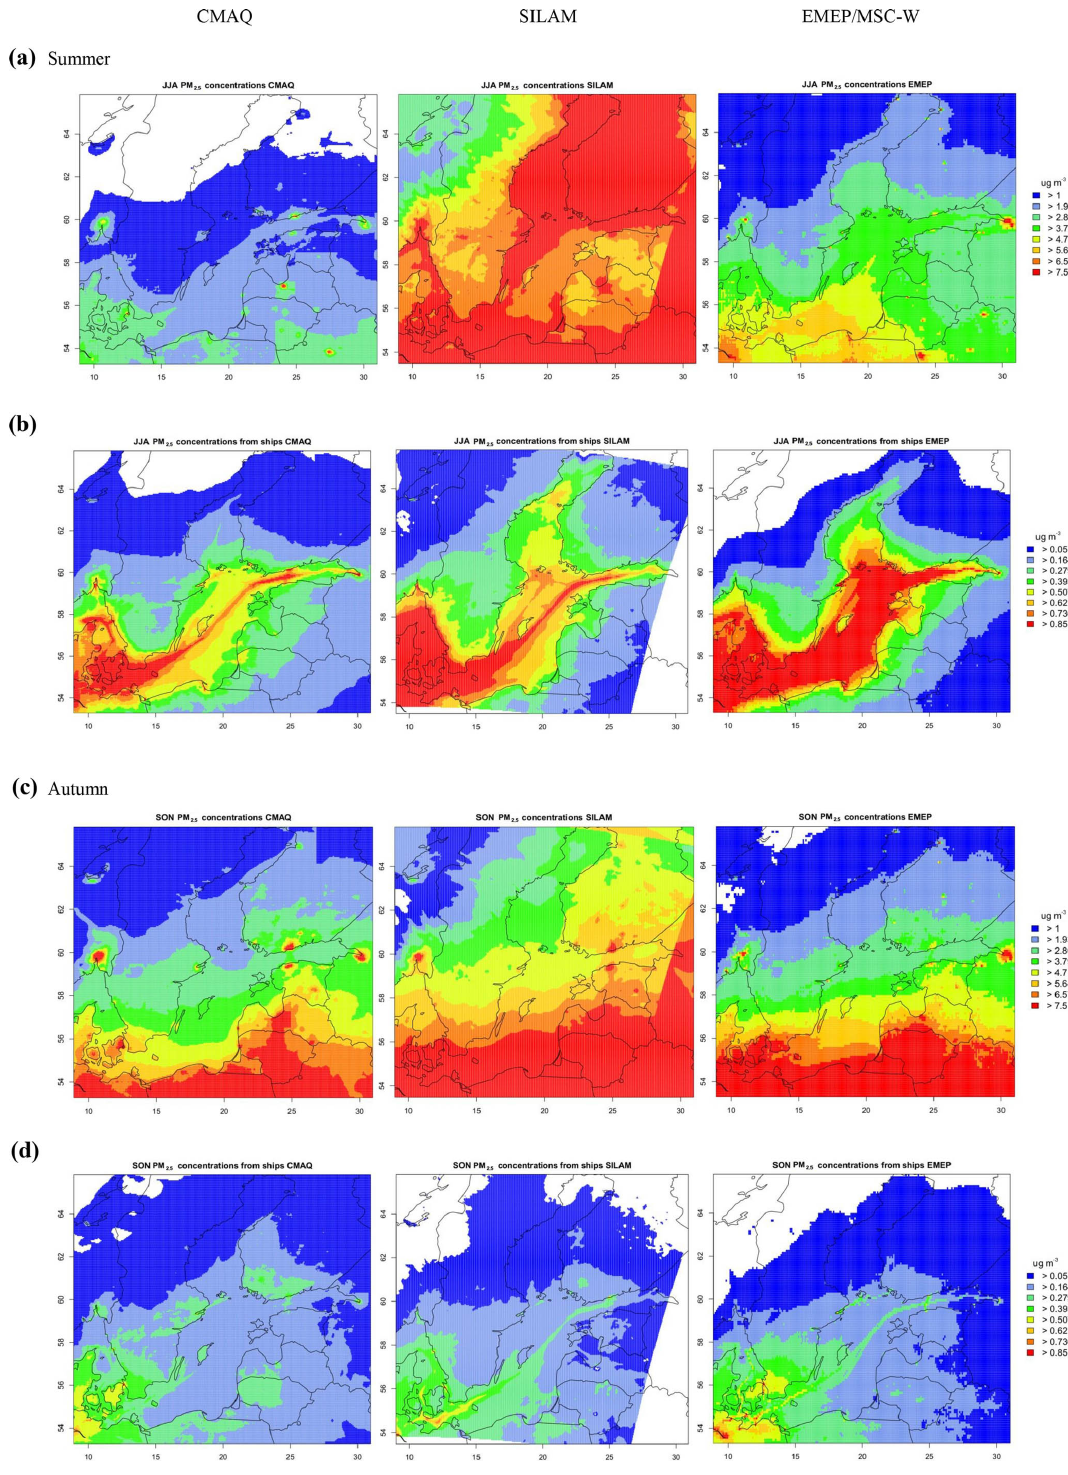
Figure 10. Comparison of PM 2 . 5 in summer and autumn from CMAQ (left column), SILAM (middle column) and EMEP (right column) in the Baltic Sea region for (a) JJA mean concentration (µgm − 3 ), (b) JJA mean ship contribution (µgm − 3 ), (c) SON mean concentration and (d) SON mean ship contribution. Empty areas correspond to concentrations between zero and the lowest value in the